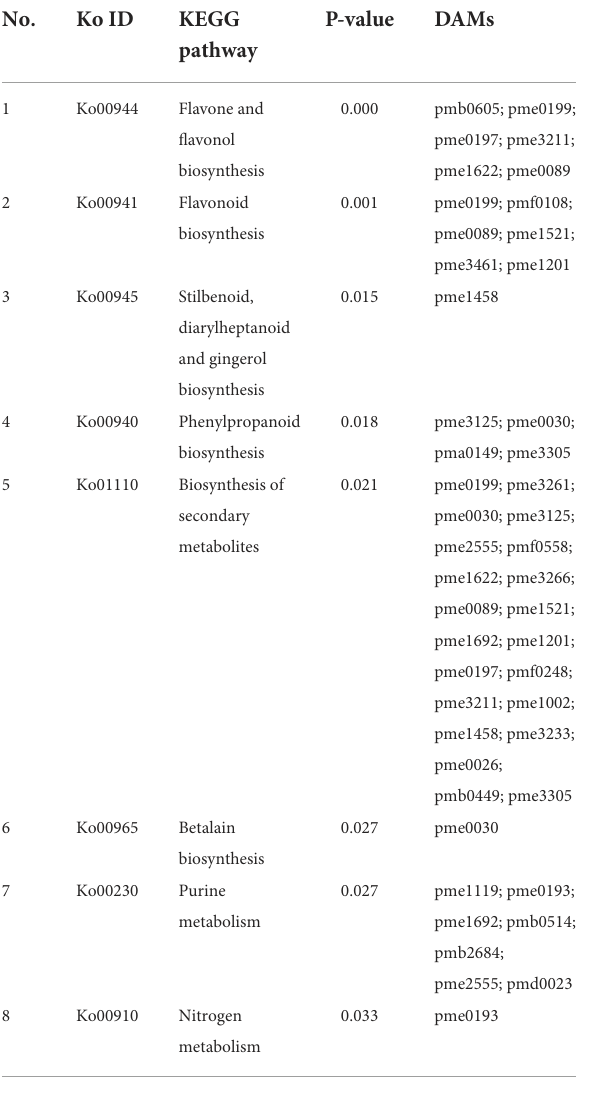
TABLE 2 The enriched pathways of differentially altered metabolites (DAMs) compared 3d + S-0h vs. 3d + S-12h in KEGG analysis. No.